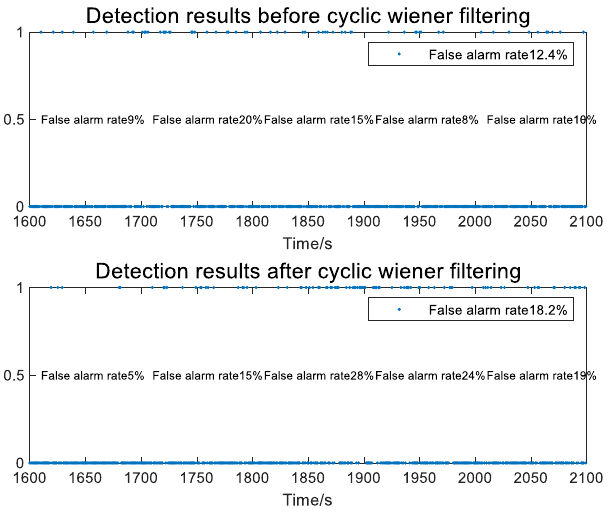
Figure 16. False alarm rate of background noise